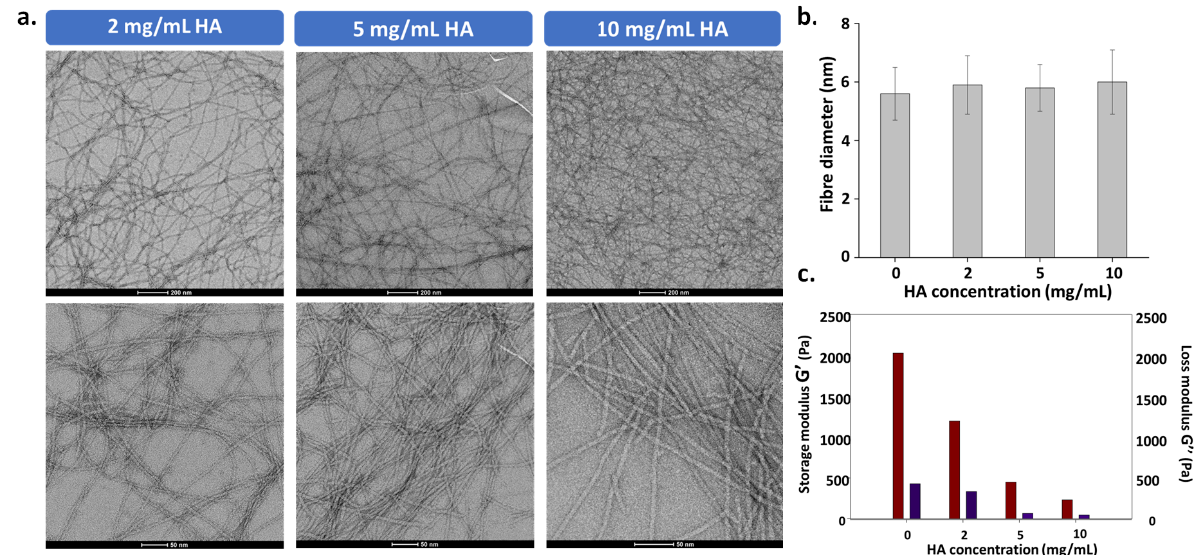
Figure 3. ( a ) The diagram provides the mean diameter of elementary fibers (ca. 30 fibers/image) determined after analysis of several TEM images (ca 10 images); ( b ) TEM images of self-assembled Fmoc-FFY nanofibers formed in presence of different HA concentrations ranging from 2, 5 and 10 mg/mL; ( c ) Elastic modulus (G’) and loss modulus (G”) values measured on hydrogels prepared in presence of 0, 2, 5 and 10 mg/mL of HA.